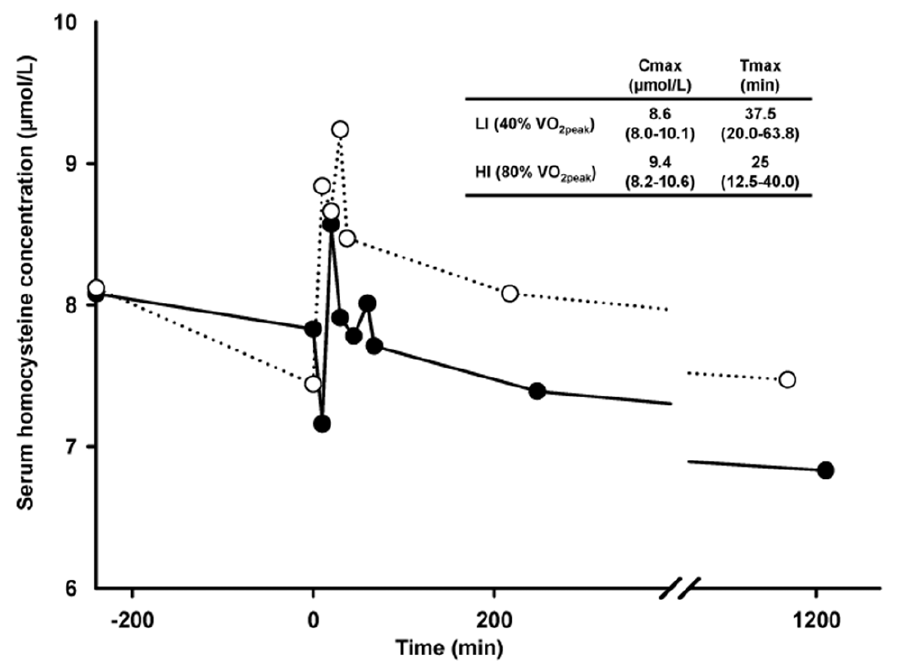
Figure 1. Serum homocysteine kinetics and calculated Cmax and Tmax at low and high intensity isocaloric exercise trials. Solid line and black dots, Low intensity exercise (40% VO 2peak ); Dashed line and white dots, High intensity exercise (80% VO 2peak ). Data are presented as medians in the figure and medians (interquartile range) in the table. *Significant differences in high intensity exercise ( P , 0.05) between pre0 vs. exer10, exer20, exer30, and post0. { Significant differences in high intensity exercise ( P , 0.05) between post19 vs. exer10, 20, 30, post0, and post 3. LI: Low intensity exercise; HI: High intensity exercise; pre0: Blood sample immediately before exercise; exer10: Blood sample 10 min during exercise; exer20: Blood sample 20 min during exercise; exer30: Blood sample 30 min during exercise; post0: Blood sample immediately after exercise; post3: Blood sample 3 h after exercise; post19: Blood sample 19 h after exercise.